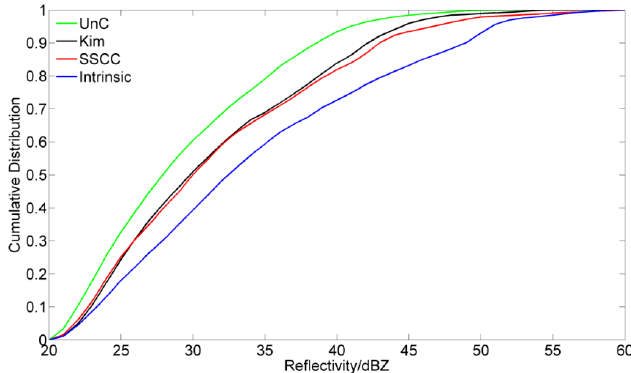
Figure 9. Cumulative distribution of reflectivity for the convective cloud. In the figure, line Unc is uncorrected reflectivity, line Kim stands for reflectivity corrected by Kim et al.’s method, line SSCC represents reflectivity corrected by the SSCC method, and line Intrinsic stands for intrinsic reflectivity.